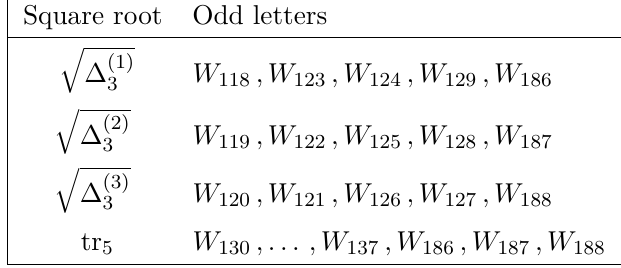
Table 7. Relevant letters which depend on the sign of the square roots of the problem. On each row the letters in the right column are odd with respect to changing the sign of the square root in √ the left column. We recall that tr 5 is related to ∆ 5 through eq.